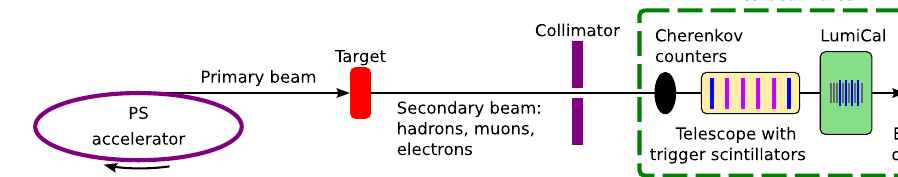
Fig. 7 Schematic view of the beam and experimental set-up (not to scale)